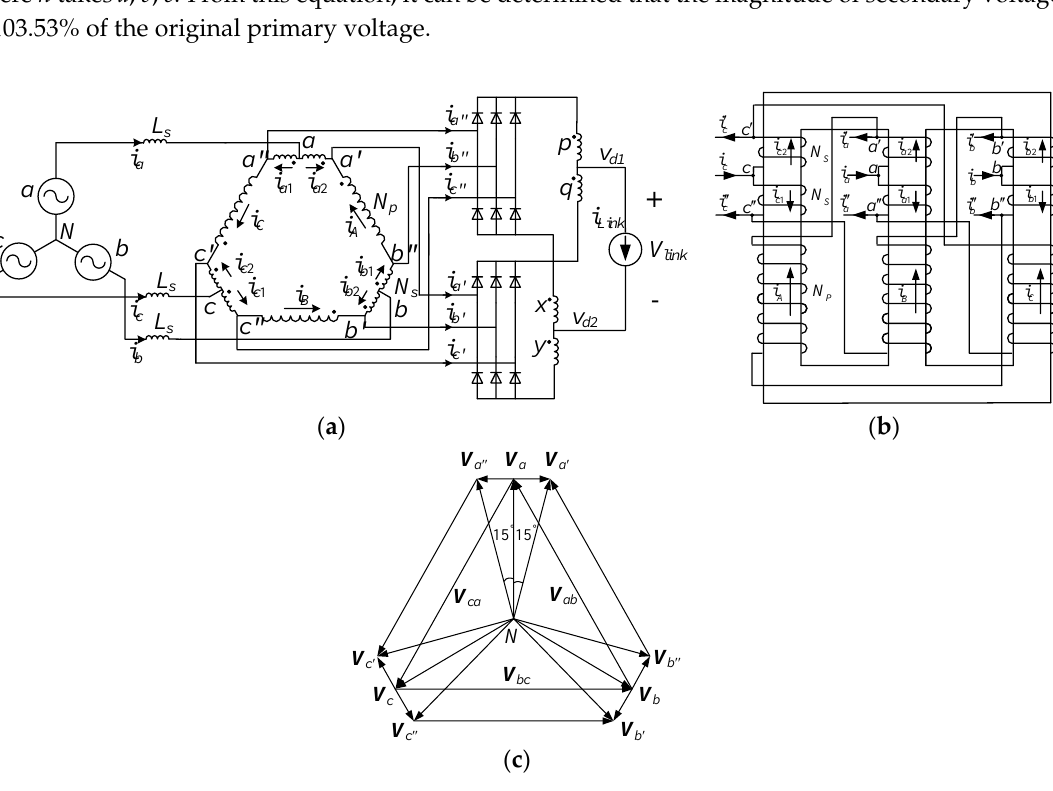
Figure 2. Configuration of the proposed 12-pulse auto-transformer rectifier unit (ATRU). ( a ) configuration of the ATRU; ( b ) windings on a three-limb core; ( c ) voltage phasor diagram.